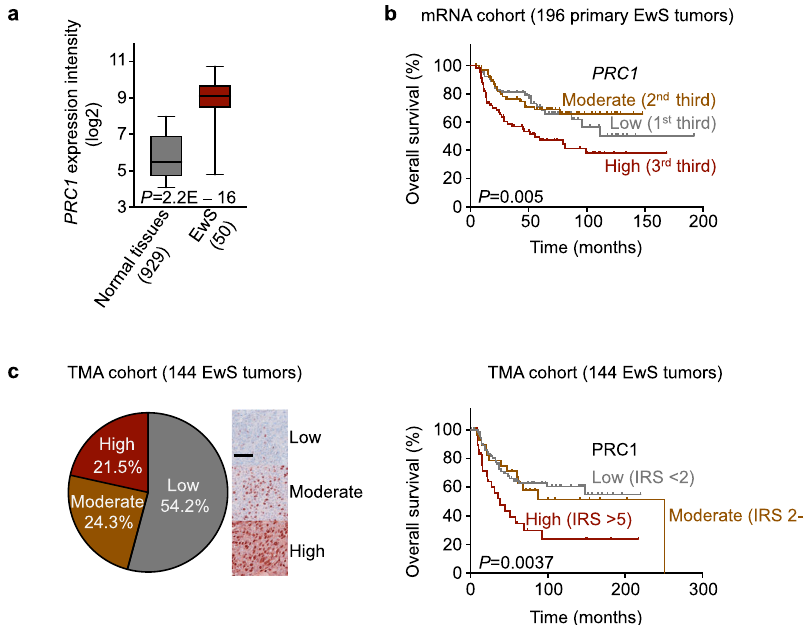
Fig. 1 PRC1 is overexpressed in EwS and correlates with poor overall survival. a Analysis of PRC1 mRNA expression in 50 EwS and 929 normal tissues (comprising 71 normal tissue types). Data are represented as box plots. Horizontal bars indicate median expression levels, boxes the interquartile range, and whiskers the 10th and 90th percentile. Two-sided Mantel-Haenszel test. b Kaplan-Meier survival analysis of 196 EwS patients strati fi ed by thirds of PRC1 mRNA expression (Low, Moderate, High). Two-sided Mantel-Haenszel test. c Left: IHC staining of a TMA comprising 144 EwS tumors for PRC1. Scale bar = 100 µ m. Right: Kaplan-Meier analysis of overall survival of 144 EwS patients strati fi ed by their intra-tumoral PRC1 expression levels (Low: IRS < 2; Moderate: IRS 2 – 5; High: IRS > 5). Two-sided Mantel-Haenszel